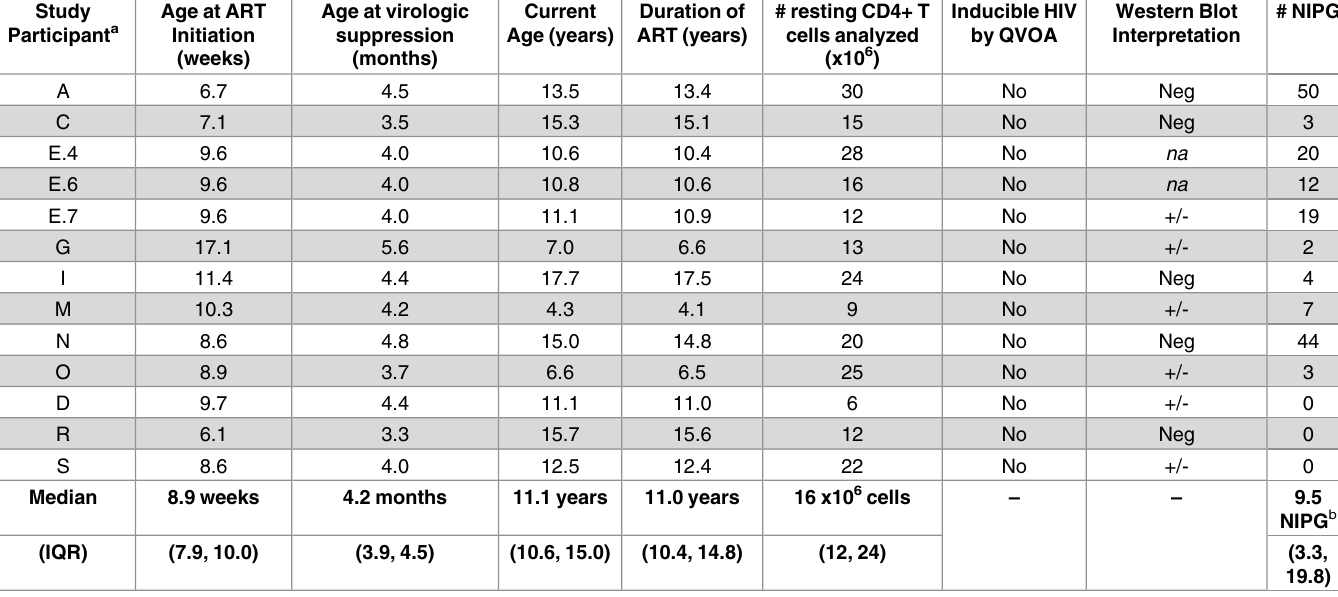
Abbreviations: QVOA, quantitative viral outgrowth assay; NIPG, non-inducedproviral genome; Neg, negative; +/-, indeterminate; na, not available. a Letter indicates participant; number indicates study visit if multiple visits. b Median (IQR) among the eight participants with NIPG